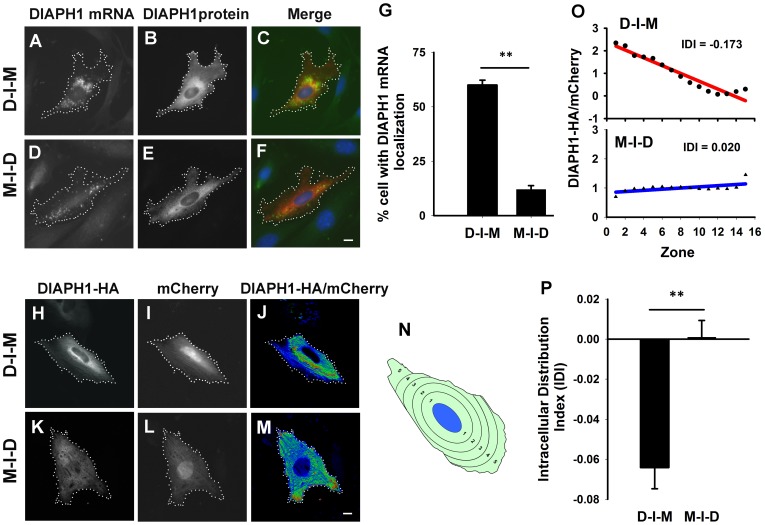
Localization of DIAPH1 mRNA correlates with DIAPH1 protein distribution.
A–F. Representative transfected cells show localization of DIAPH1 mRNA and protein. A–B and D–E are gray scale images for the distribution of DIAPH1 mRNA and protein in NIH3T3 cells transfected with the construct of D-I-M (A–C) or M-I-D (D–F), respectively. Their merged images are shown in C or F. G. Quantitative results of DIAPH1 mRNA localization from analysis of 300 cells from three independent experiments for each expression construct. Error bars: sem. ** p<0.01. H–P. Analysis of the relationship of localization of DIAPH1 mRNA and its protein distribution in NIH3T3 cells. H–I and K–L are gray scale images for distribution of DIAPH1-HA fusion protein and mCherry in NIH3T3 cells transfected with the construct of D-I-M (H–I) or M-I-D (K–L), respectively. Their merged images are shown in J or M. N. Illustration of a cell with 5 equal-area zones according to their relative distance to the nucleus border. Note that the shape of the zones are listed in the carton is simplified one and is likely vary within a cell (see Methods and Materials for details). O. Scatter plot graphs show two individual quantitative results of intracellular DIAPH1-HA fusion protein distribution in single NIH3T3 cells transfected with the construct of D-I-M and M-I-D, respectively. The red and blue color lines are linear regression for the ratio points of D-I-M or M-I-D transfected cells. P. A bar graph shows average IDI value for D-I-M or M-I-D transfected cells from analysis of 30 cells for each expression construct. Error bars: sem. ** p<0.01.